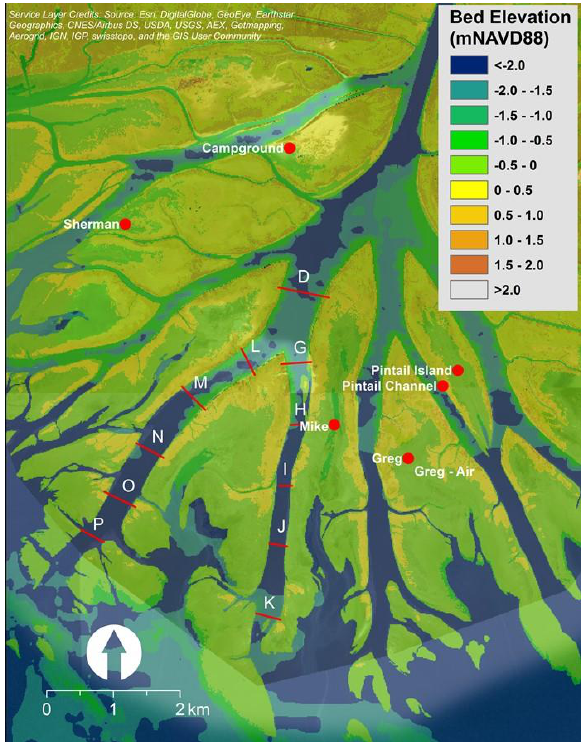
Figure A1. Map showing location of water level, discharge, and velocity measurements.